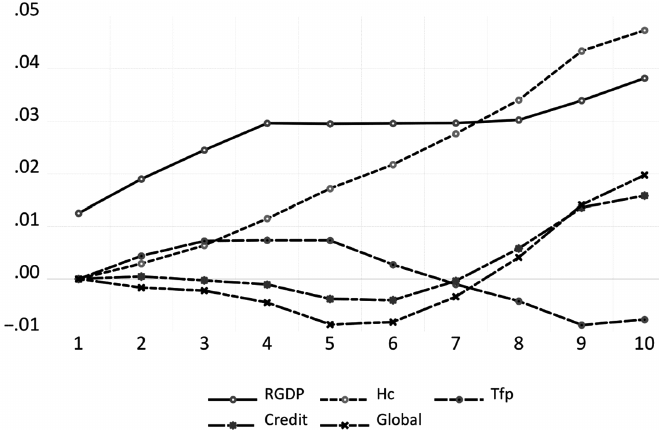
Figure 5. Response of RGDP to Innovation (with lFIRMS) (source: authors’